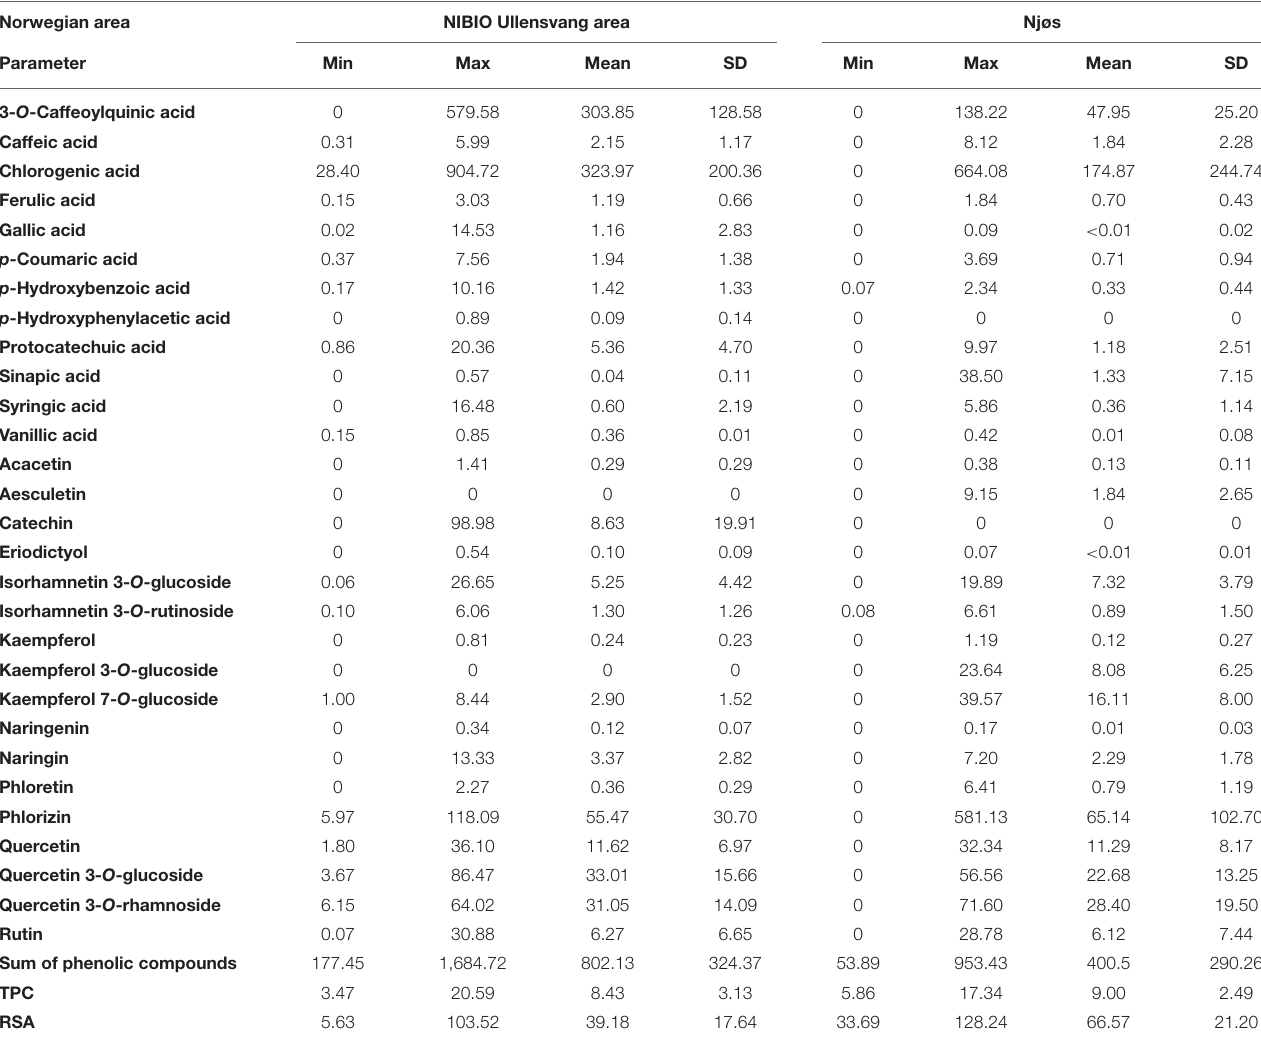
TABLE 4 | Descriptive analysis of the content of phenolic compounds (mg/kg dw), total phenolic content (TPC, g GAE/kg dw), and relative scavenging activity (RSA, mmol TE/kg dw) in Norwegian apple samples from the NIBIO Ullensvang area (no. 1–74) and from Njøs (no. 75–103) during 2-year harvesting. Norwegian area NIBIO Ullensvang area